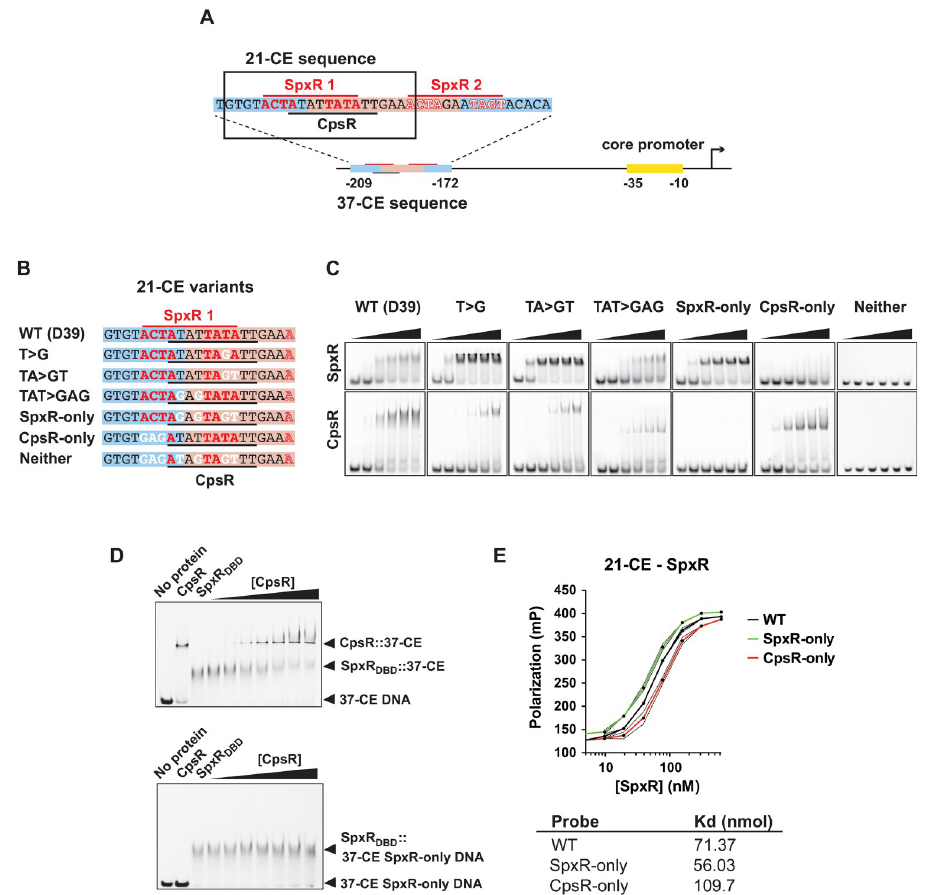
Fig 2. SpxR and CpsR binding to the 37-CE . ( A ) Schematic diagram of the cps promoter and 21 / 37-CE sequences. The 21-CE sequence is boxed. ( B ) Oligos used to determine specific nucleotides required for SpxR and CpsR binding. Red line and red residues: proposed SpxR1 inverted repeat binding site and minimal required nucleotides for interaction. Black line: proposed refined CpsR binding site (this work). White labelled nucleotides were mutated. ( C ) Representative EMSAs of 21-CE oligos depicted in B . ( D ) (Above) representative EMSA showing that CpsR competes for SpxR DBD binding to the 37-CE oligo. (Below) representative control EMSA showing that CpsR is unable to compete for SpxR DBD binding in the absence of its binding motif. EMSAs were performed three times. ( E ) Fluorescence polarization of WT, SpxR-only and CpsR-only 21-CE DNA variants with full-lenfth SpxR protein. Polarization is expressed in millipees (mP). The mean of three independent experiments is plotted. Error bars represent standard deviation and are indicated by dashed lines. Average equilibrium dissociation constants (Kds) are given